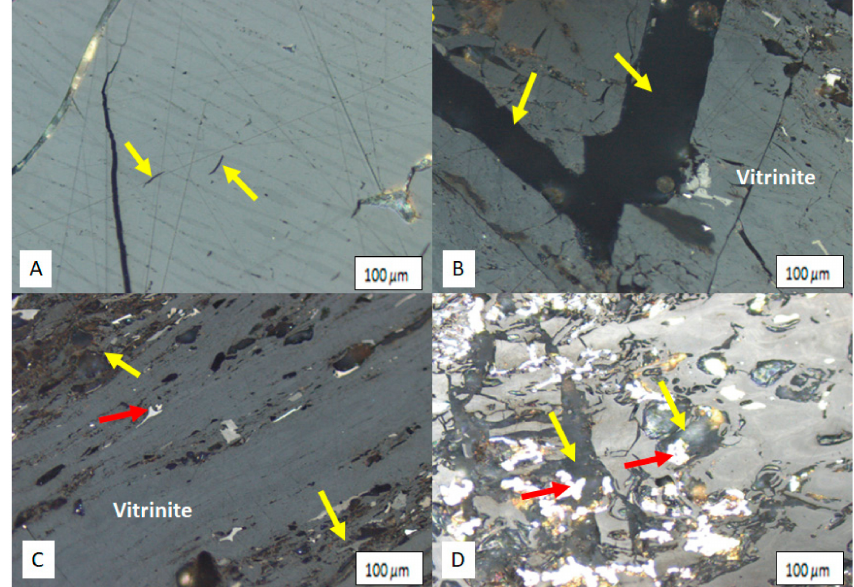
Figure 5. Photomicrographs of coal showing: ( A ) pseudovitriite; ( B ) vitrinite and sporinite (yellow arrows); ( C ) vitrinite, clay minerals (yellow arrows), and inertodetrinite (red arrow); and ( D ) quartz (red arrows) fillings in vitrinite (yellow arrows).